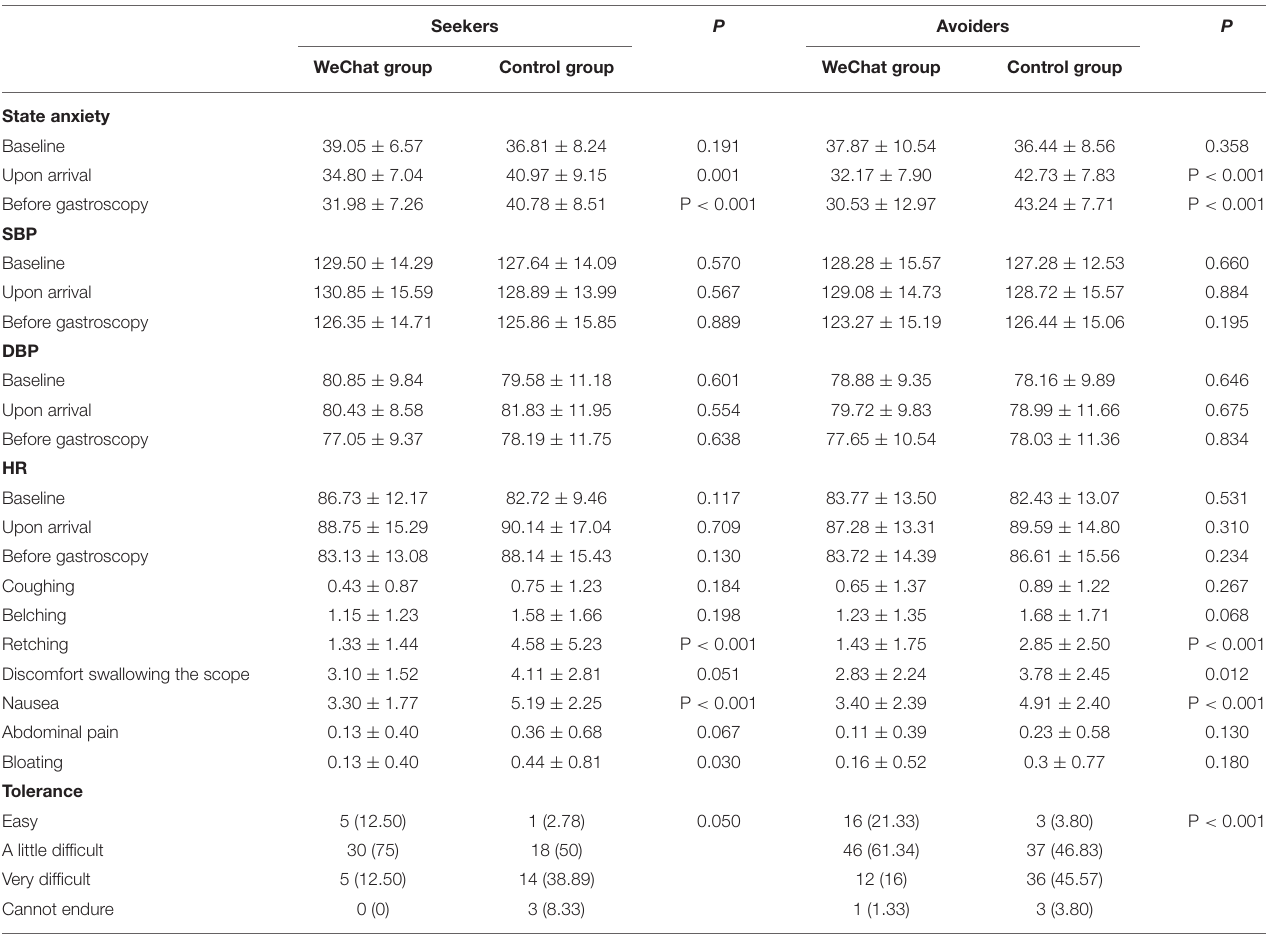
TABLE 2 | Anxiety level at baseline, upon arrival and before gastroscopy, and patient cooperation and tolerance by information seekers and avoiders in each of the two information groups. Seekers P Avoiders P WeChat group Control group WeChat group Control